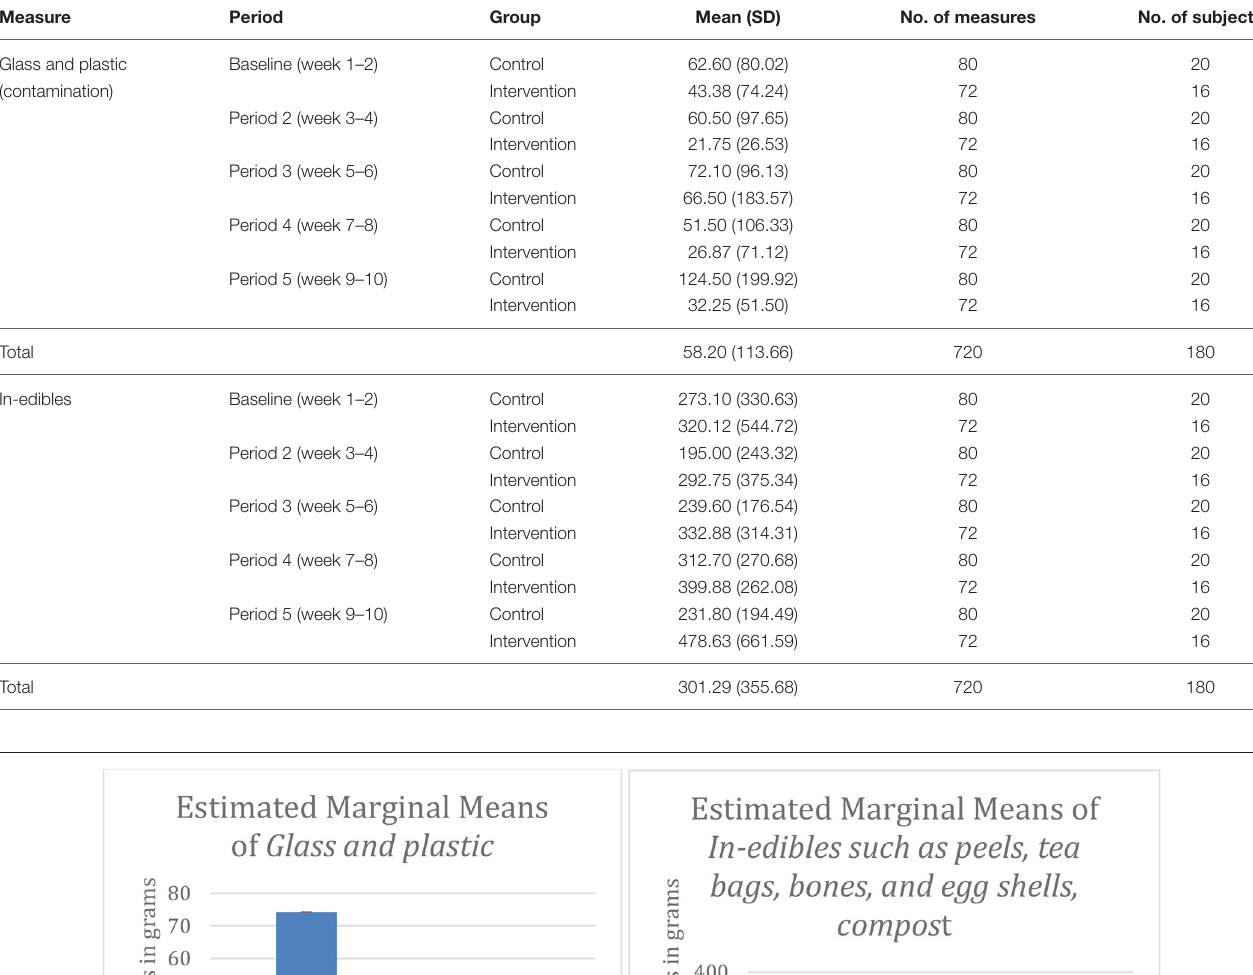
TABLE 4 | Means (in grams), standard deviation (SD), and number of test subjects (N) for all five 2-week periods of the waste measures contamination with glass and plastic and in-edibles where the main effect Group is significant (period 1 = baseline). Measure Period Mean (SD) No. of measures